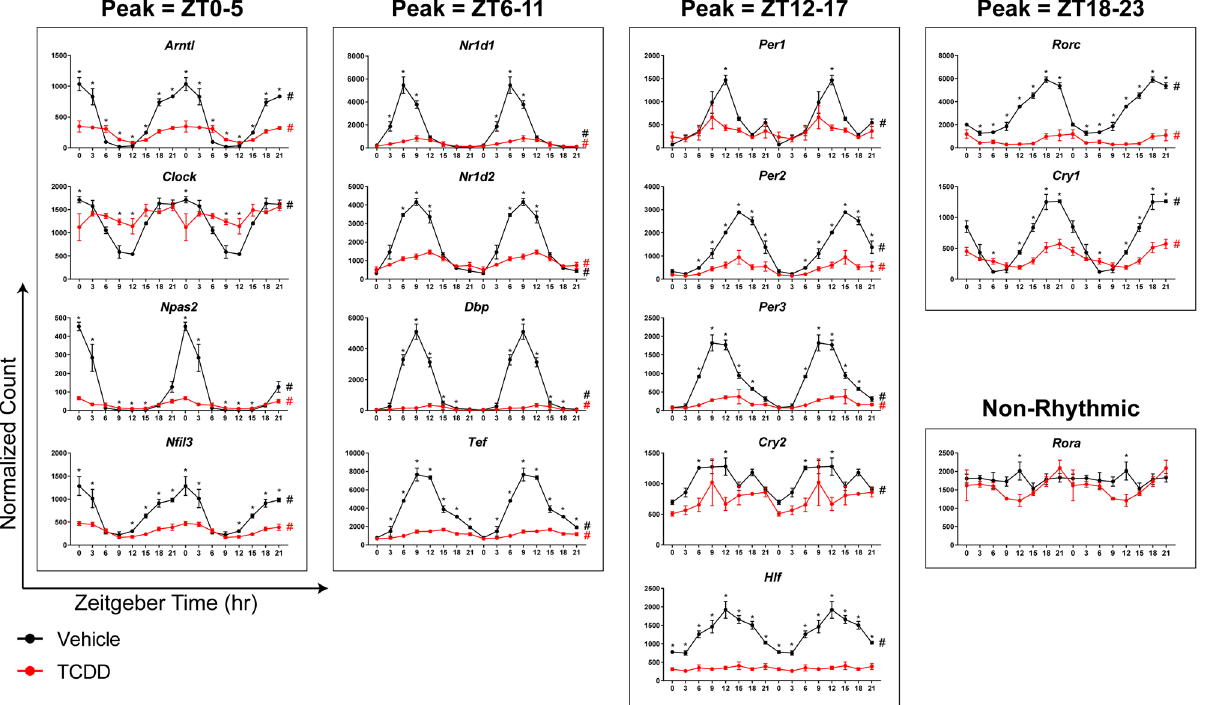
Figure 3. RNA-Seq analysis of core hepatic clock regulators in male C57BL/6 mice orally gavaged with sesame oil vehicle or 30 µ g/kg TCDD every 4 days for 28 days. Data points represent the average of 3 individual mice ± standard error of the mean. Posterior probabilities ( * P1(t) ≥ 0.80) comparing vehicle and TCDD were determined using an empirical Bayes method. Diurnal rhythmicity was assessed using JTK_CYCLE (# BH q ≤ 0.1). Genes are grouped by their acrophase (time at which gene expression peaks/crests in cycle) in vehicle mice. Data are double-plotted along the x-axis for better visualization of